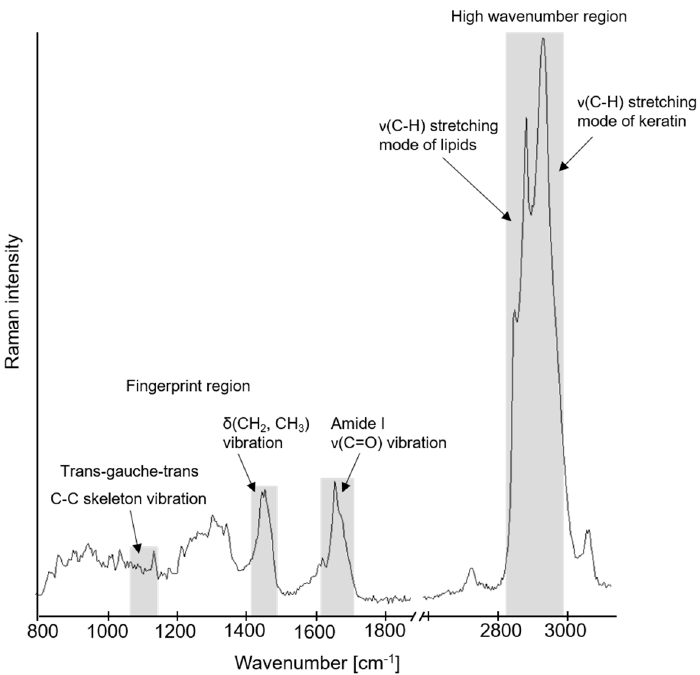
Figure 1. Typical confocal Raman spectroscopy spectrum of stratum corneum with highlighted peaks used for calculation of lipid content and order.